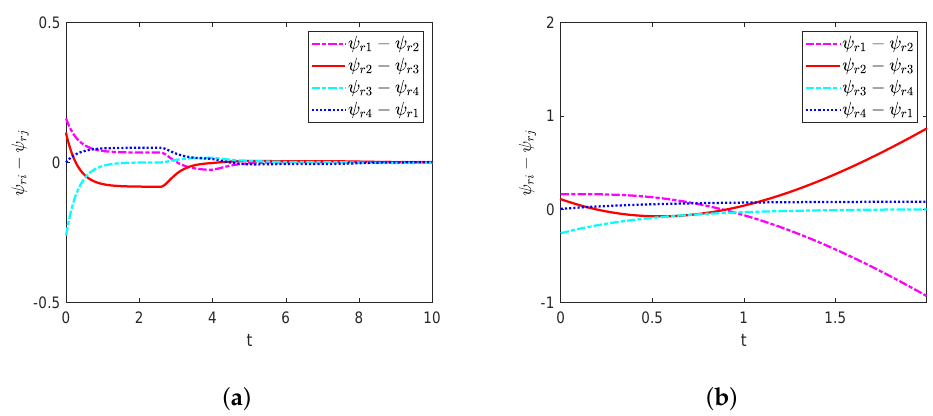
Figure 3. Formation in the case of ( a ) the proposed controller and ( b ) the non-delay